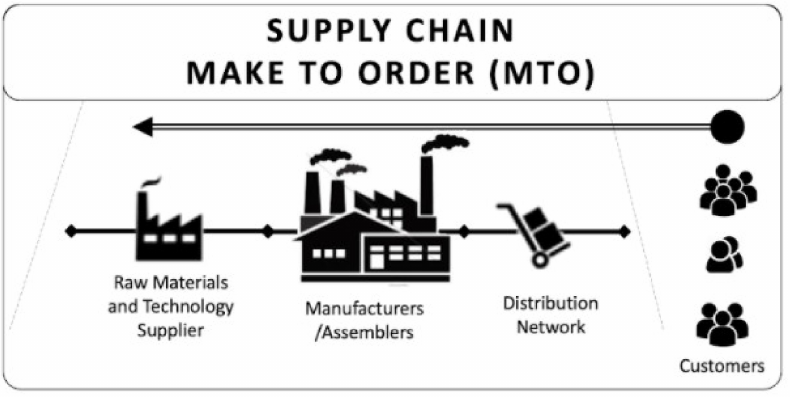
Figure 3. Operation model. Order-based supply chain (MTO). Source: own